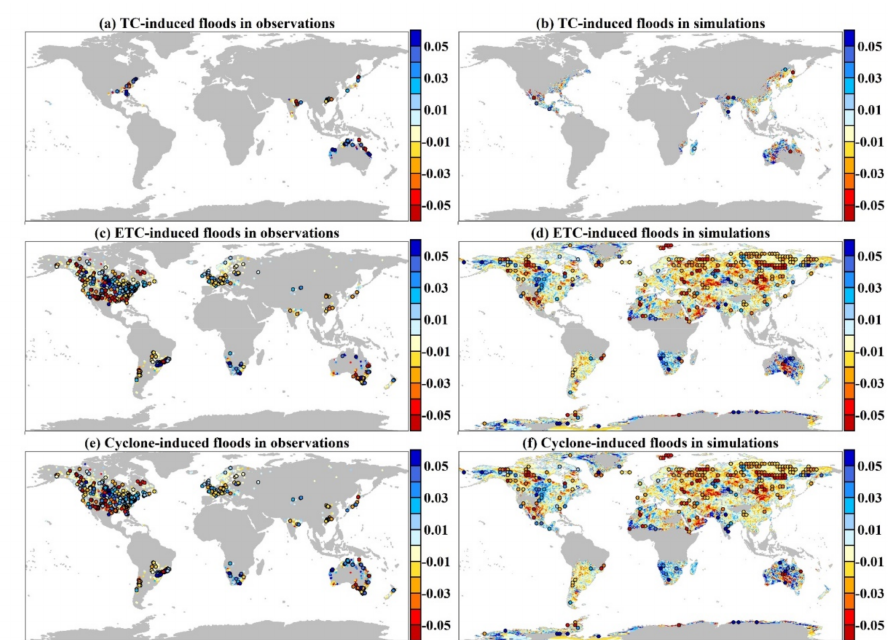
Figure 7. Long-term changes in the magnitude of TC, ETC, and cyclone-induced floods in observations ( a , c , e ) and simulations ( b , d , f ) during 1979–2012. The trend is quantified by the simple linear regression, and the colored points (grids) based on observations (simulations) represent slope coefficient β 1 in Equation (1). A higher probability of BM floods induced by cyclones with increasing (decreasing) magnitude are detected when β 1 is more (less) than zero. Moreover, the larger ring-shaped dots indicate the stations with significant change rate.